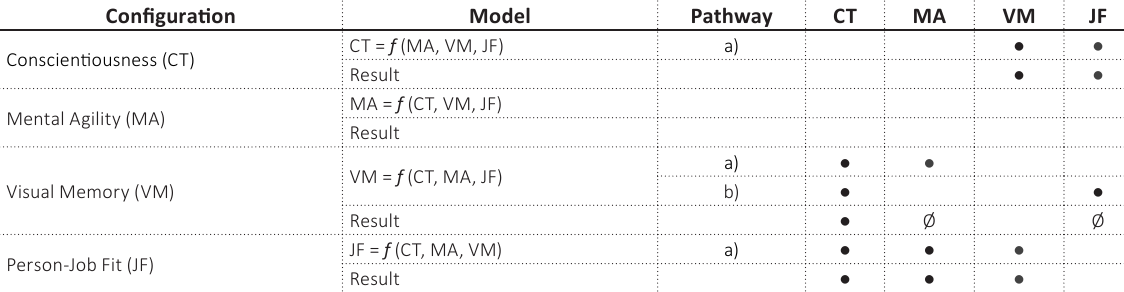
Table 5. fsQCA results